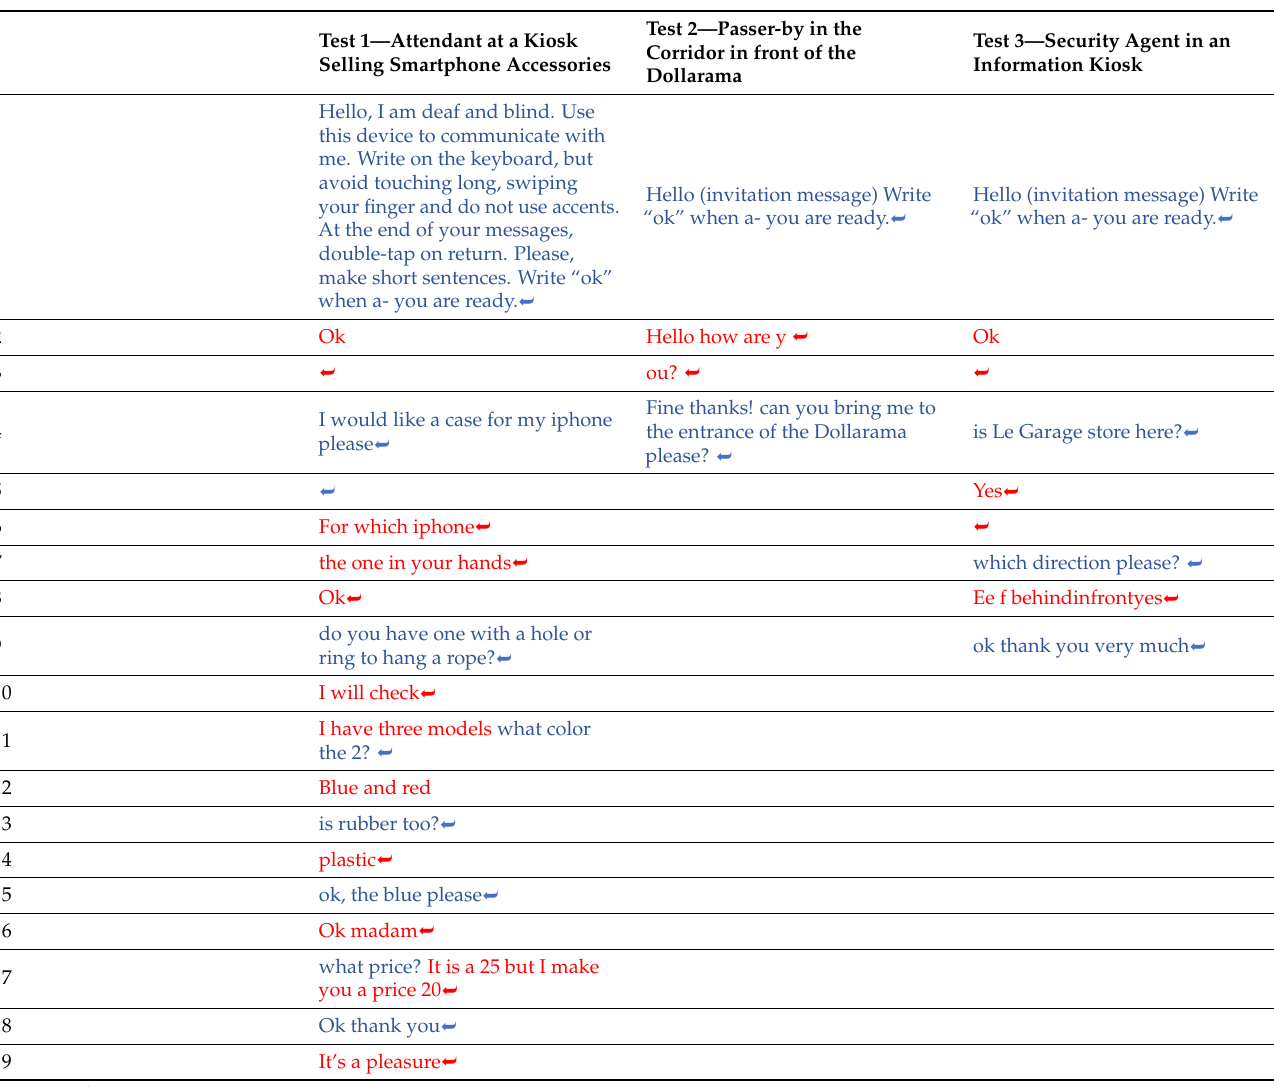
Return button corresponds to the symbol “  ” in blue and red and defines row breaks in the table.